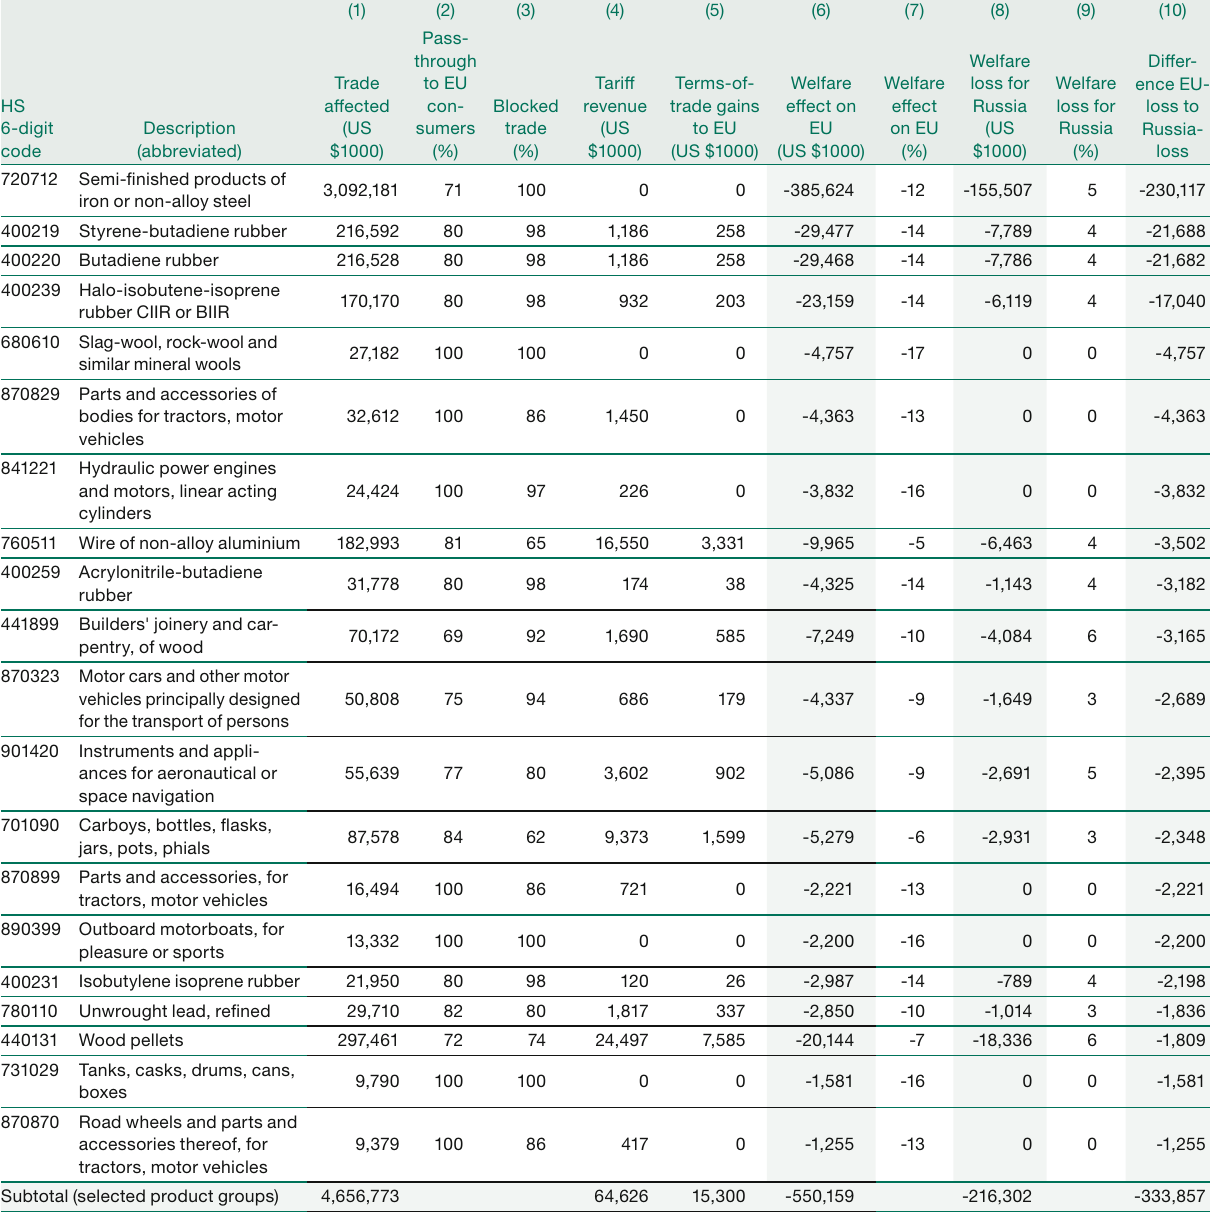
Sectors in which balance of harm to Russia and self-harm to the EU is